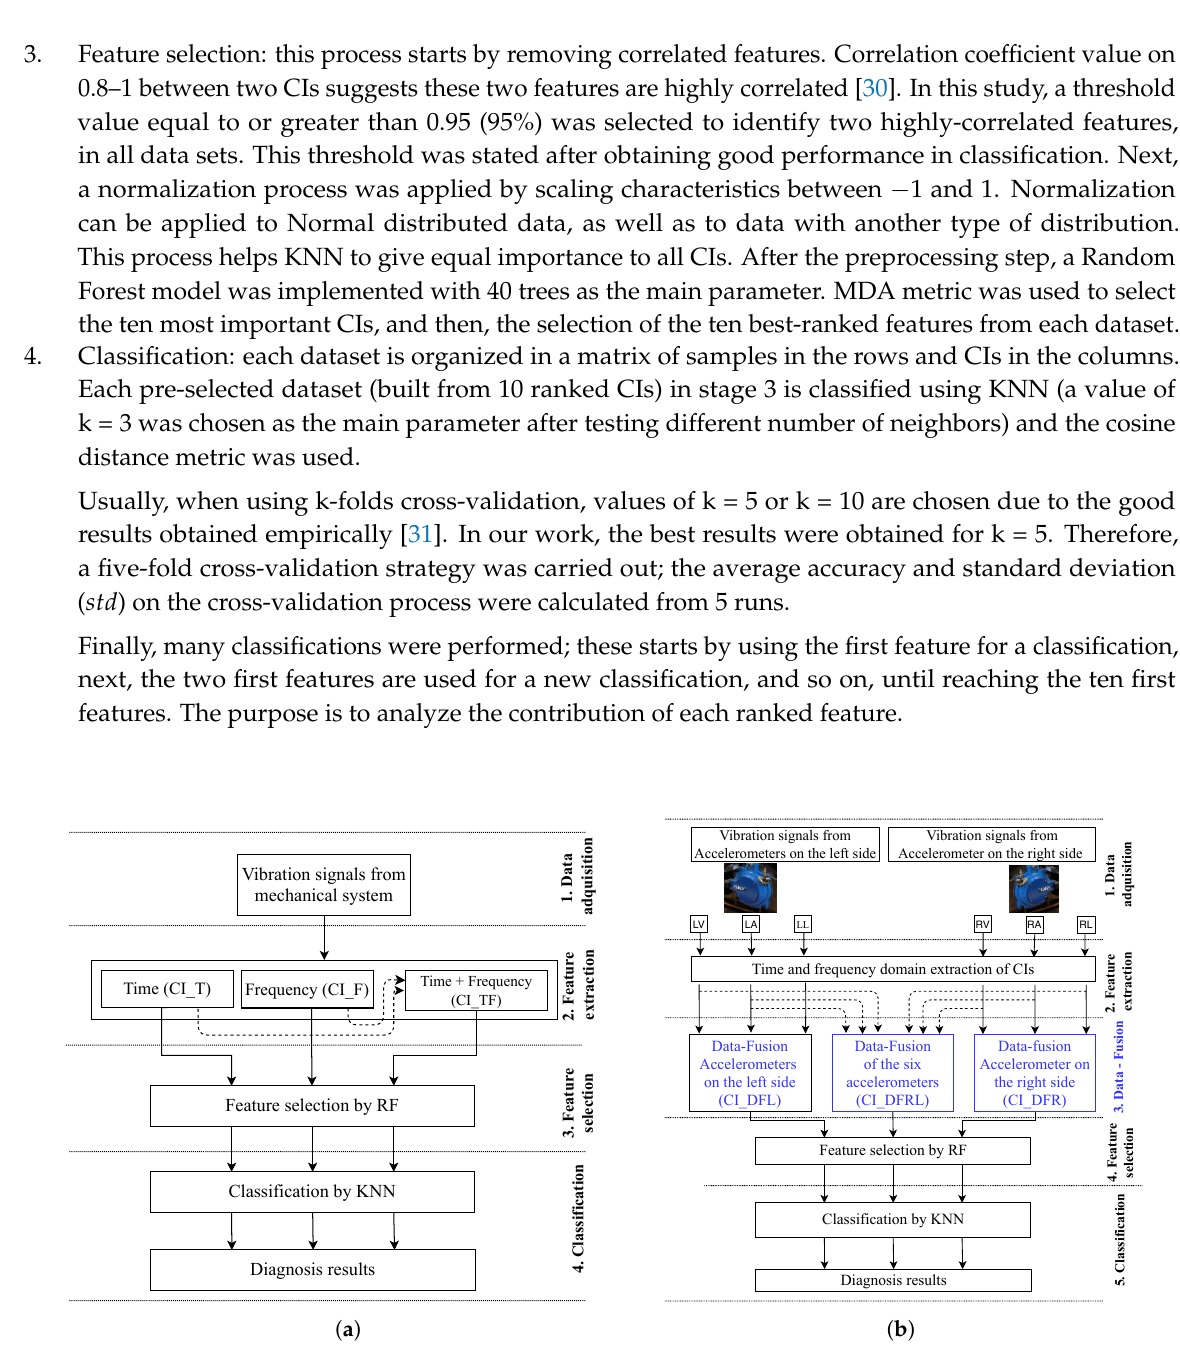
Figure 3. Flowcharts of the proposed approaches. ( a ) Flowchart approach 1 ( b ) Flowchart approach